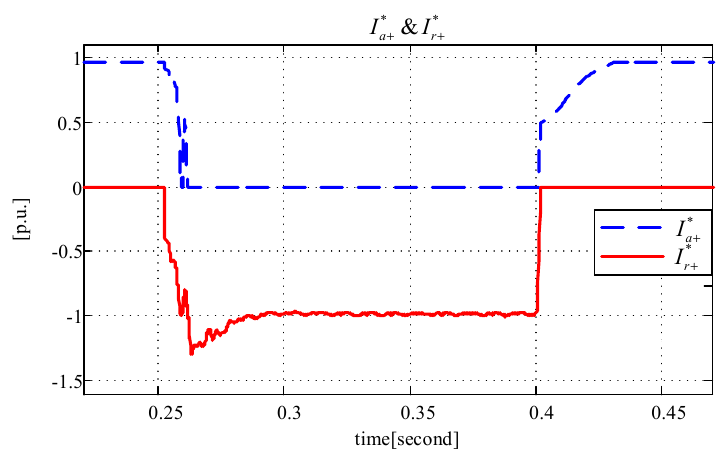
Figure 17 . Set points of active and reactive currents in positive sequence for voltage faults: V ag = 0.5 p.u., V bg = 1.8 p.u., V cg = 1.8 p.u., with anti-saturation for SCR = 5.